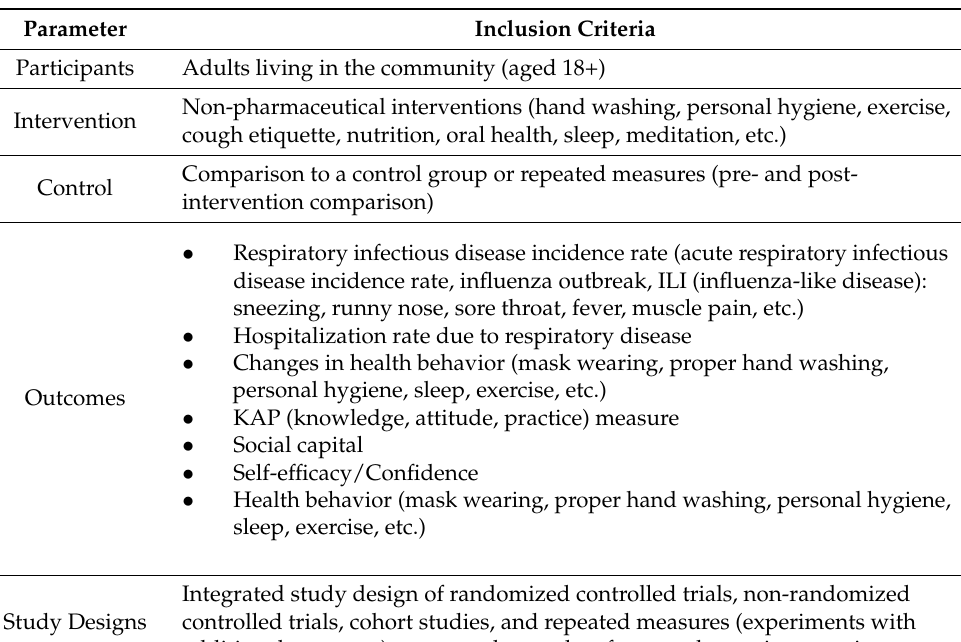
Table 1. Inclusion criteria based on Participants, Intervention, Control, Outcomes, and Study Designs (PICOS) strategy in the present